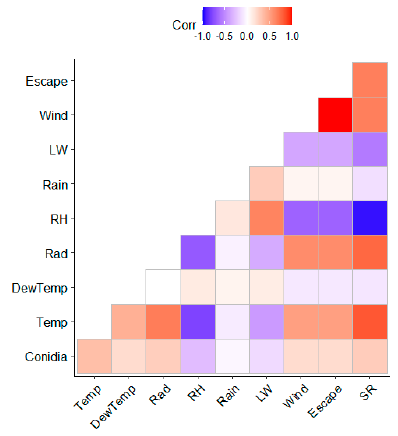
Figure 4. Heatmap with Spearman correlations between hourly conidia concentration and weather parameters. The selected weather variables were relative humidity (RH), temperature (Temp), wind speed (Wind), dew temperature (DewTemp), leaf wetness (LW), solar radiation (Rad), and rainfall (Rain).